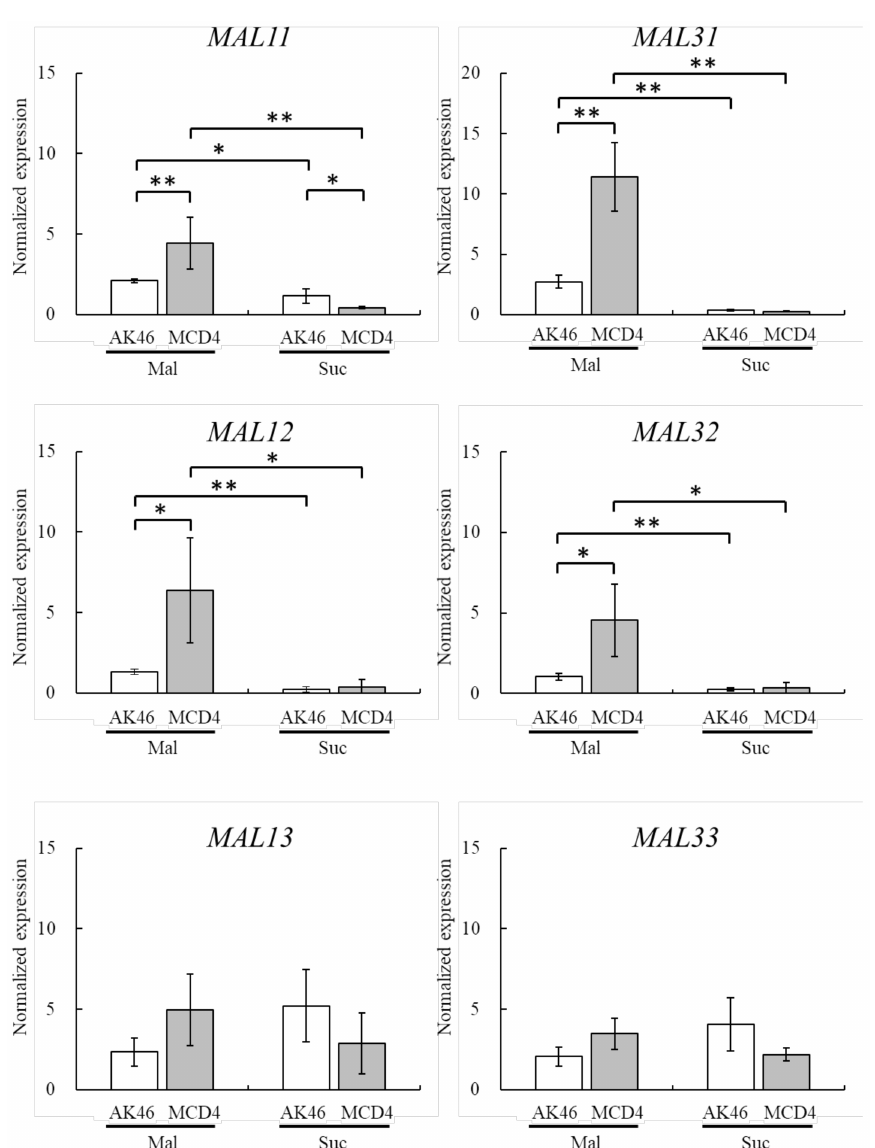
Figure 2. Relative expression of maltose metabolism-related genes ( MAL11 , MAL12 , MAL13 , MAL31, MAL32 , and MAL33 ) in S. cerevisiae AK46 and MCD4 incubated in maltose- or sucrose-medium. The values are shown as the means ± S.D. (standard deviation) of three replicates. Mal: maltose, Suc: sucrose. * p < 0.05; ** p < 0.01 (Student’s t